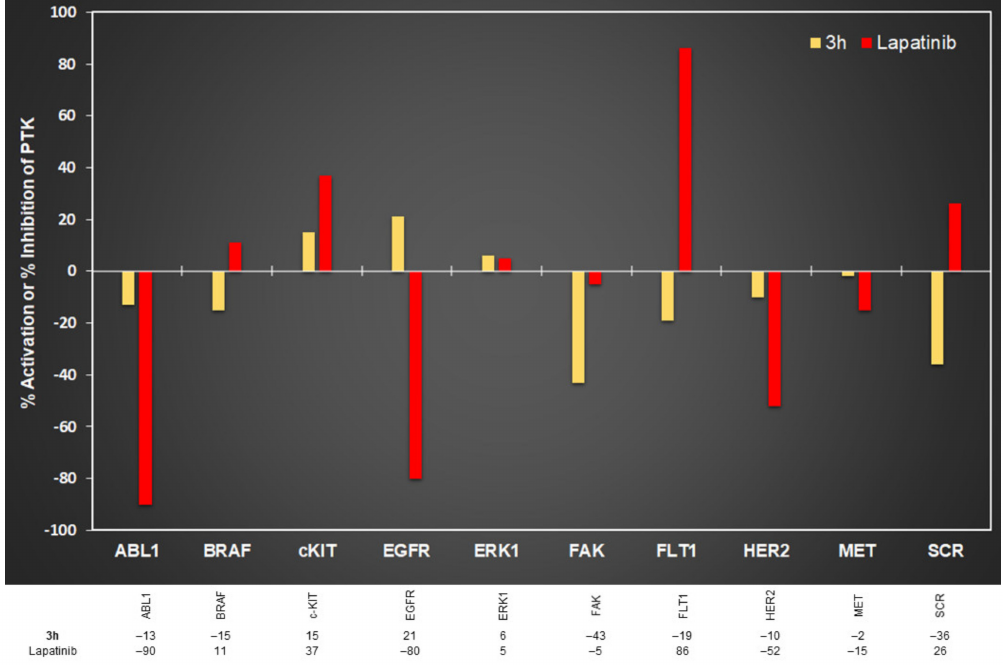
Figure 8. Protein kinase profiling for compound ( 3h ) at 10 µ M concentration against 10 PKs compared to